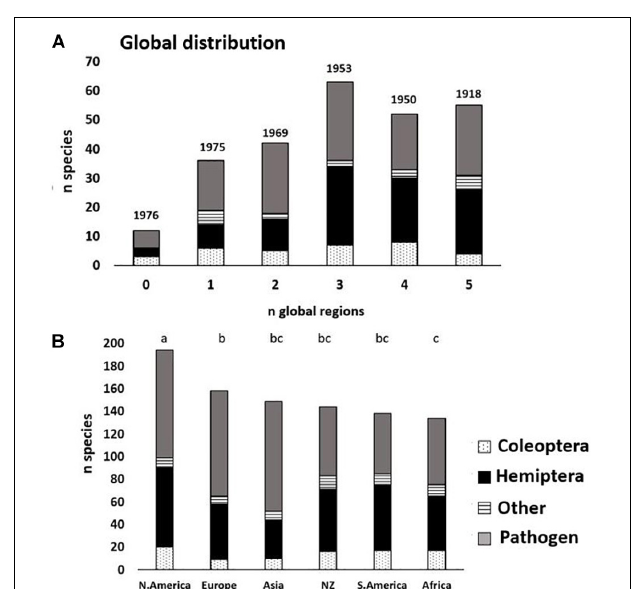
FIGURE 5 | Invasive range score (number of global regions) for the non-native forest pests established in Australia ( n = 260) (A) ; and their distribution as non-native species throughout these global regions (B) (Coleoptera = stippled; Hemiptera = black; other = striped) and pathogen (gray) species. Above bars is shown the median year of Australian establishment for the species in those global regions (A) and letters that designate significant differences in frequencies of species in common among global regions (B)